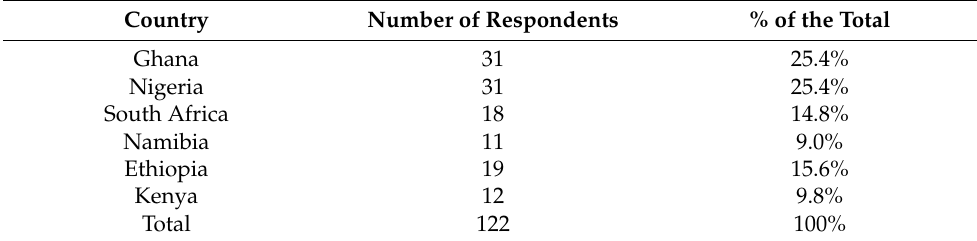
Table 2. The number of respondents from the sampled